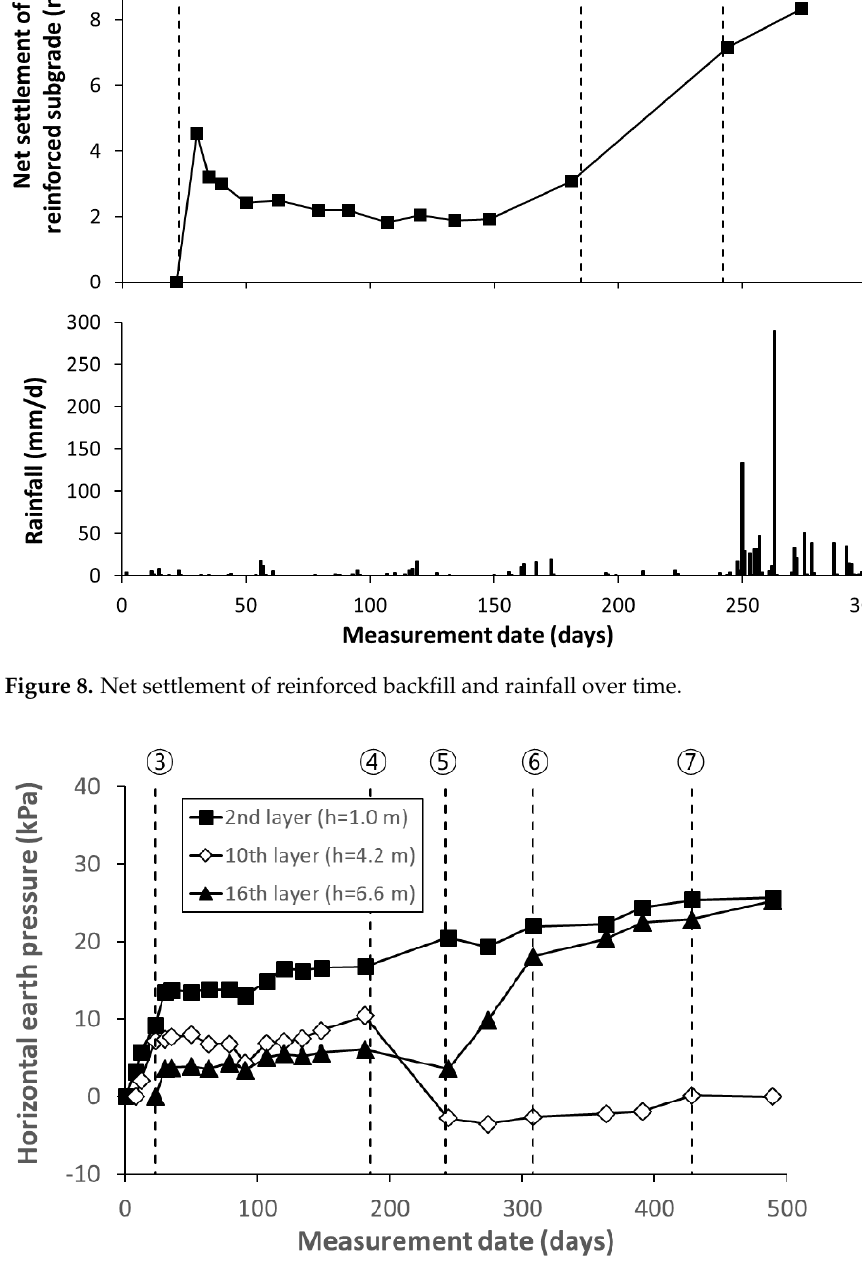
Figure 9. Variation of the horizontal earth pressure over time.